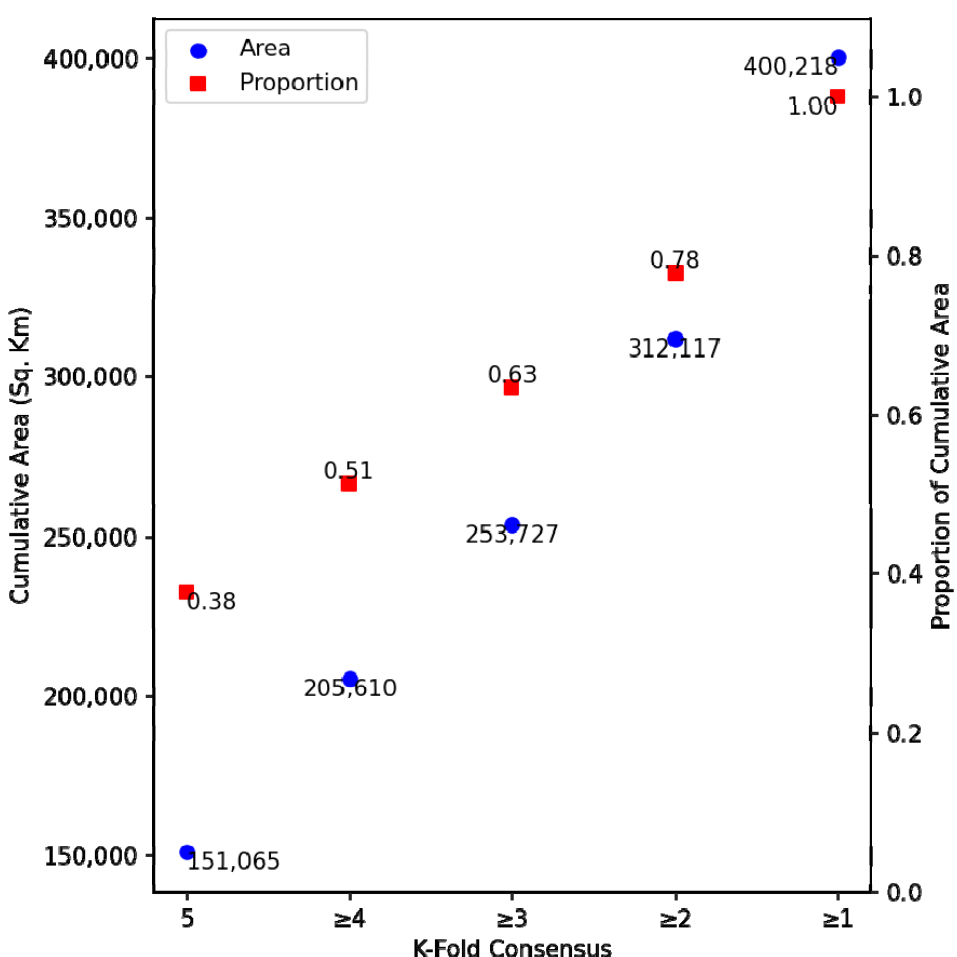
Figure 7. Cumulative areas (blue dots) and proportions (red squares) of the predicted area occupied by cheatgrass for each k -fold consensus